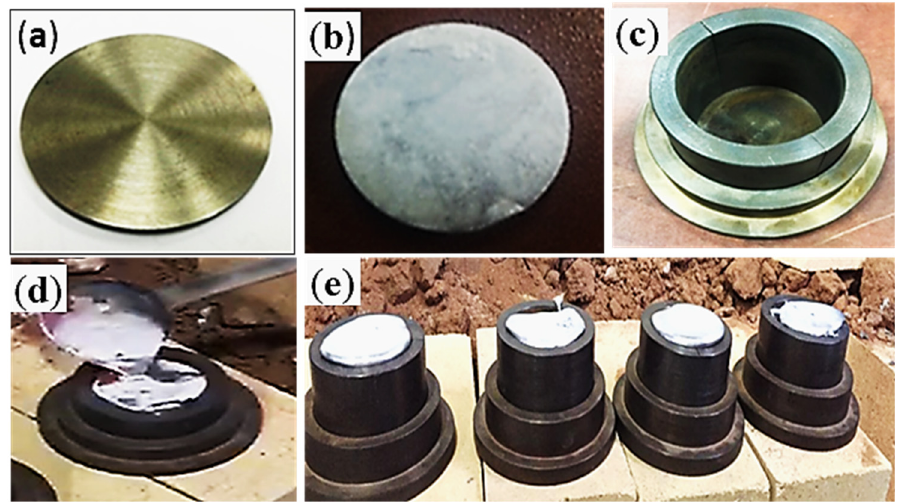
Figure 1. Solid steel substrate ( a ), tinned steel substrate ( b ), metallic mold ( c ), pouring molten Al-based bearing alloy onto tinned steel substrate ( d ), and bimetallic castings after pouring ( e ).